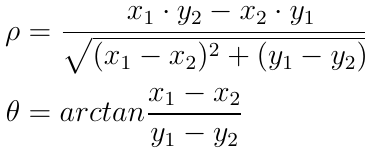
Figure 3. Constrained Hough transform applied to detect triangular, rectangular and arrow